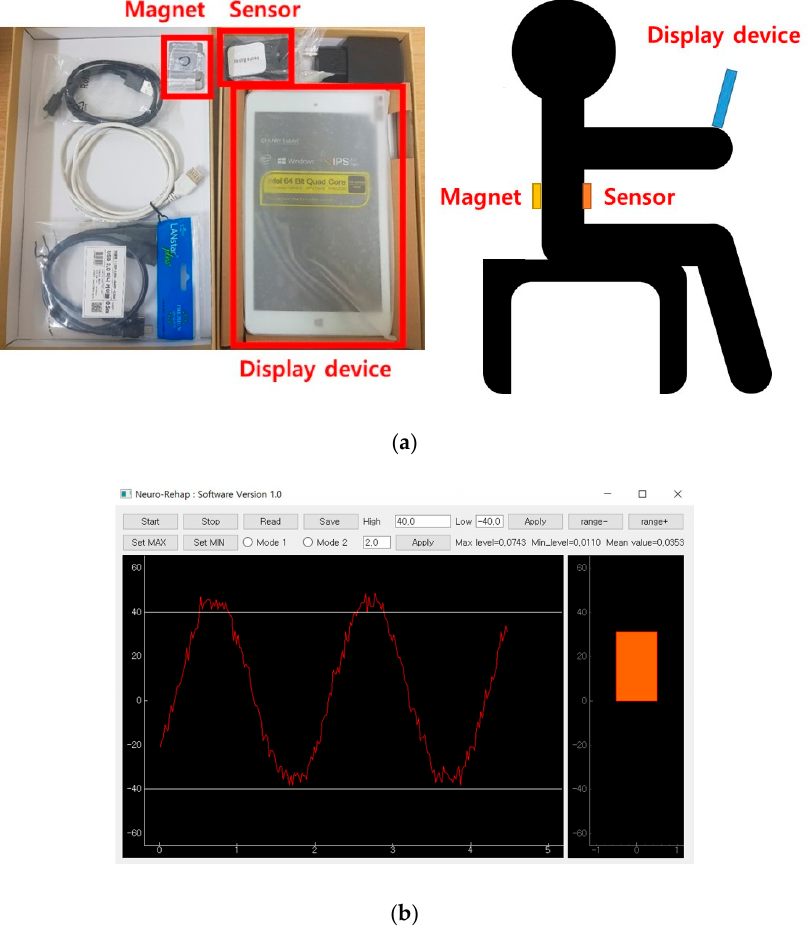
Figure 1. ( a ) The hardware part of the respiratory monitoring and training system; ( b ) breath pattern output device displaying the position of the sensor in a bar graph. In the graph, the x -axis represents time(s) and the y -axis represents height ratio (%) of sensor position.